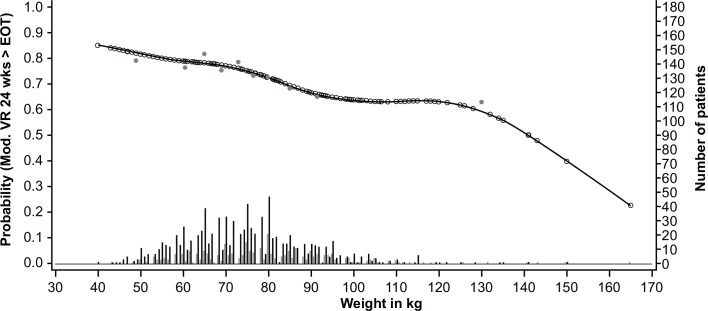
Relationship between bodyweight and sustained virologic response (SVR).Short vertical lines indicate the number of patients with SVR (black lines) and no SVR (grey lines). Open circles represent probability of SVR according to the GAM analysis. Closed circles represent empirical probability for midpoints of deciles.